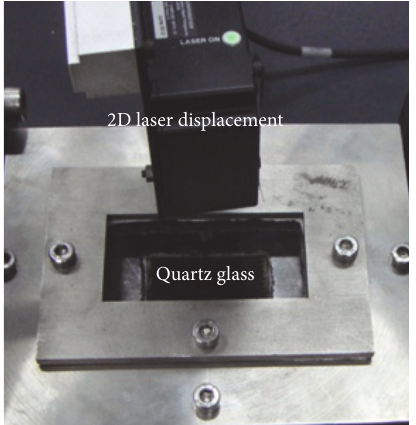
Figure 3: The visualization